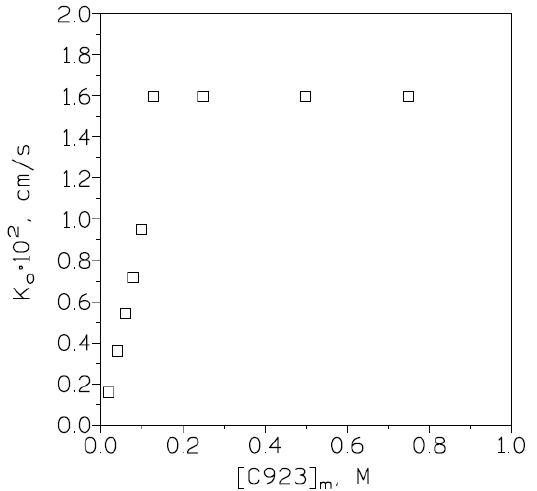
Figure 4. Variation in K o versus carrier concentration in the membrane phase. Membrane support: GHVP4700. Temperature: 20 °C.